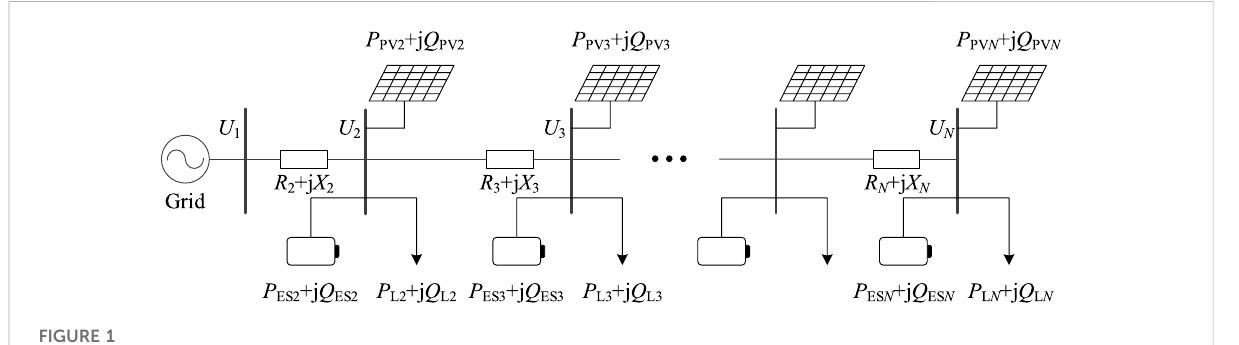
FIGURE 1 Structure of distribution network with the single